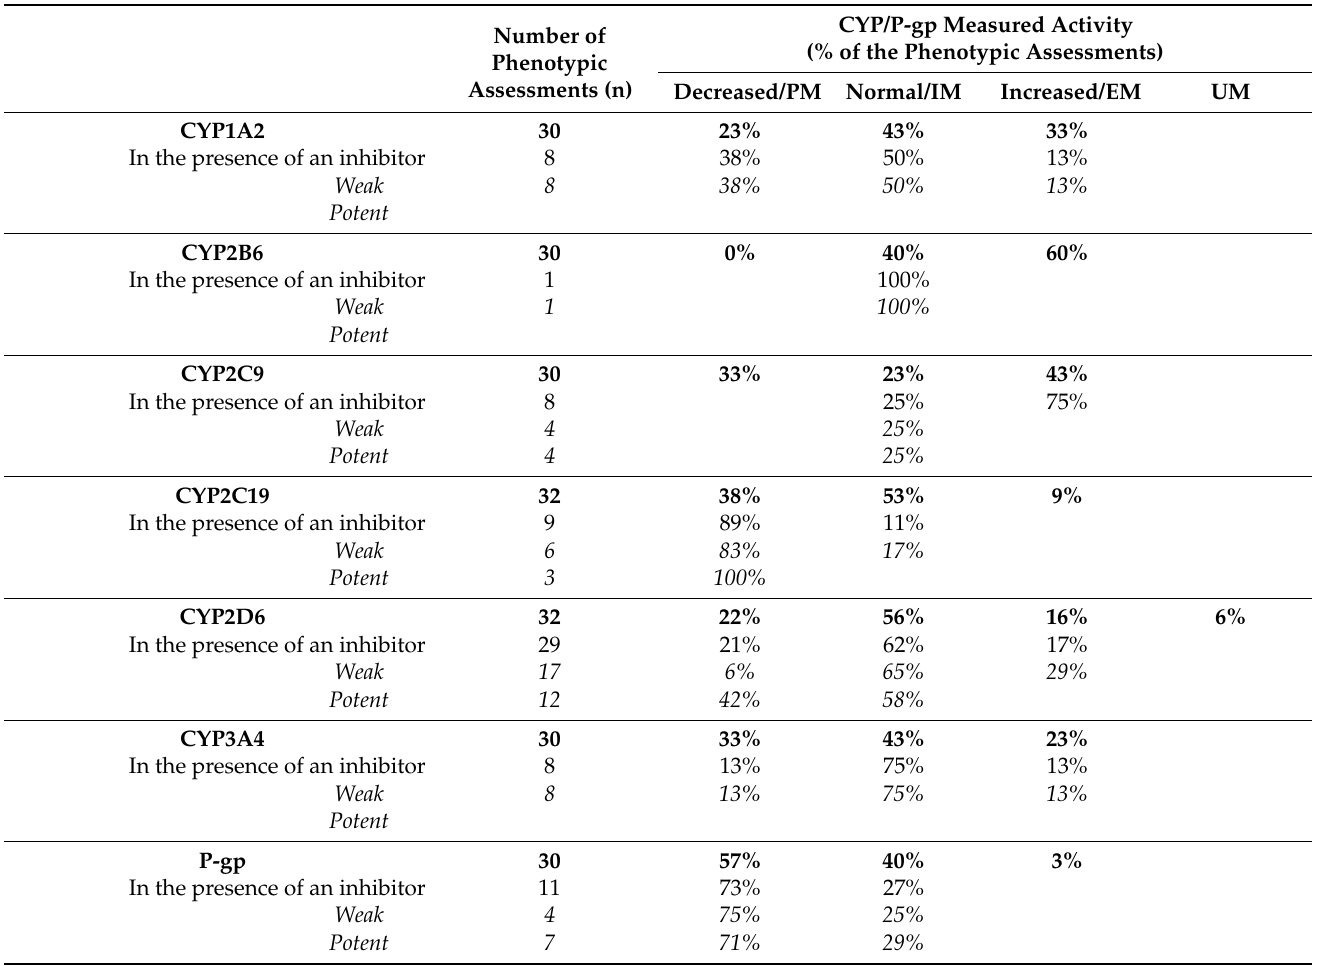
Table 4. Cytochrome (CYP) and P-glycoprotein (P-gp) measured activity in the presence and absence of an inhibitor. Number of (% of the Phenotypic Assessments) Phenotypic Assessments (n)